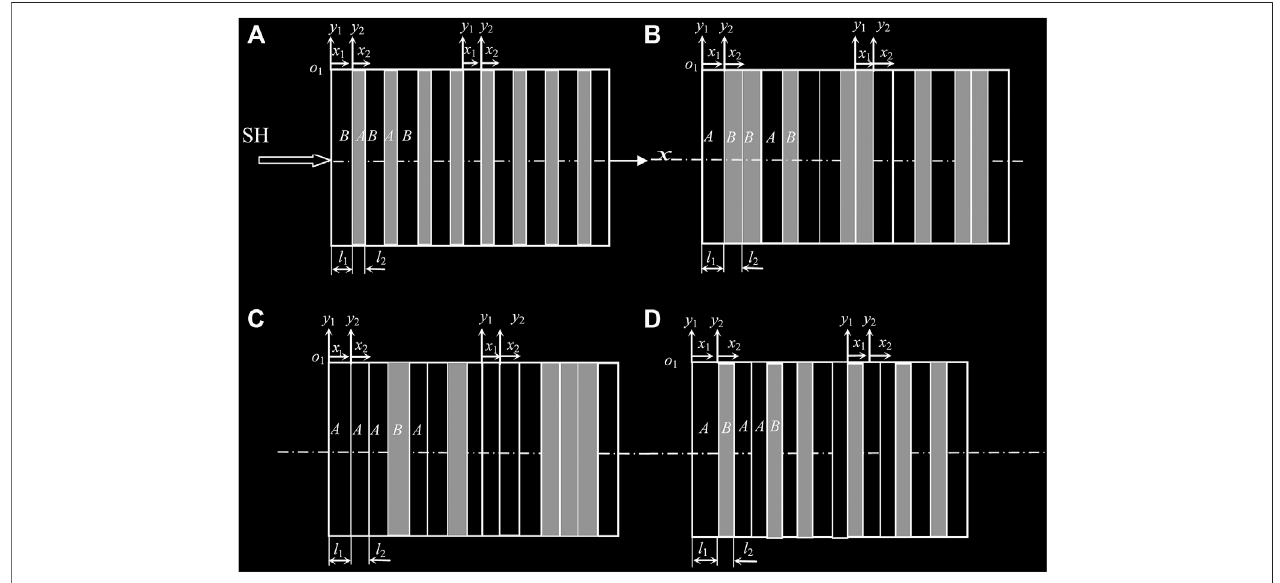
FIGURE 1 | The schematic of the SH wave propagating normally in the nanoscale periodic layered structure (A) , the layered PCs arranged as Thue-Morse sequence (B) , Rudin-Shapiro sequence (C) and Fibonacci sequence (D) .